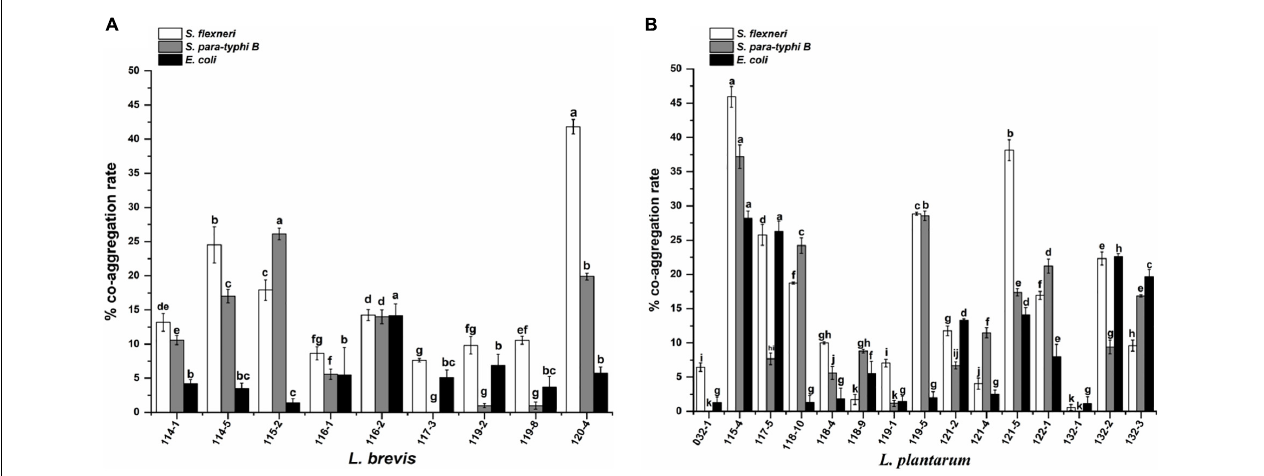
FIGURE 3 | Co-aggregation of pathogenic bacteria with (A) Lactobacillus brevis strains and (B) Lactobacillus plantarum strains isolated from fermented vegetables in Shaanxi, China. The values represent the mean ± SD of three different assays. Different letters indicate significantly different means ( P < 0.05).